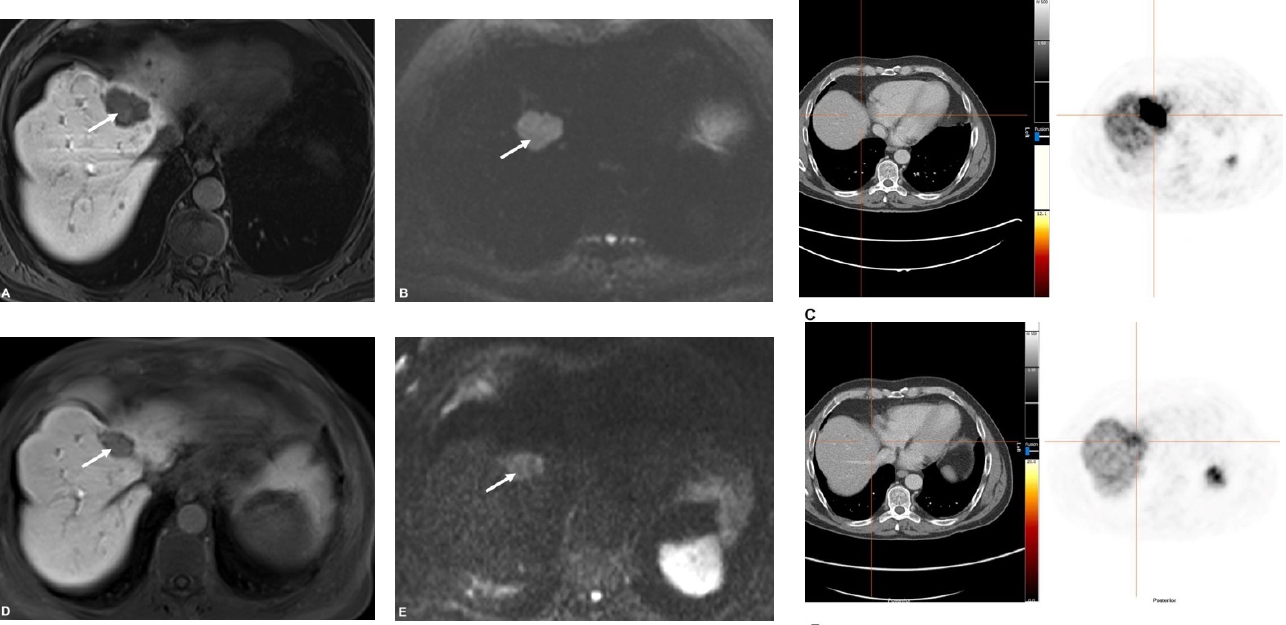
Figure 4. Patient with PR after TARE. In this patient, the liver metastasis showed hypointense signal on liver-specific phase ( A ), restricted diffusion ( B ), and SSR overexpression ( C ) before TARE. Postinterventionally, there was a significant shrinkage in size ( D ), less diffusion restriction ( E ), and a decrease of SSR overexpression ( F ) indicating partial response.